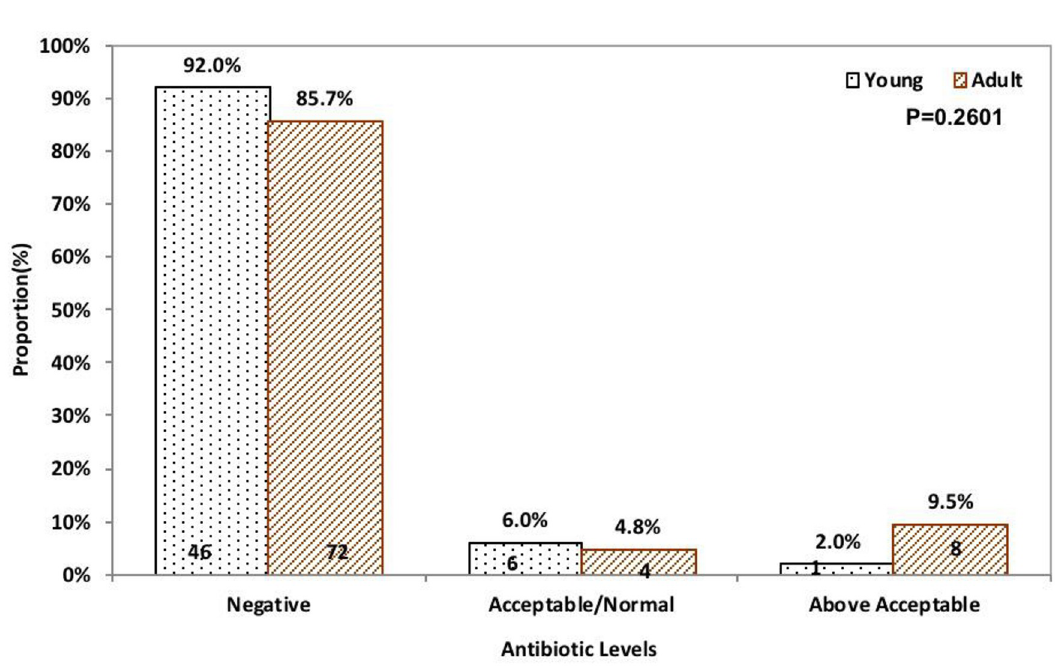
Fig 3. Tetracycline levels by age (beef carcass counts are at the bottom of bars).